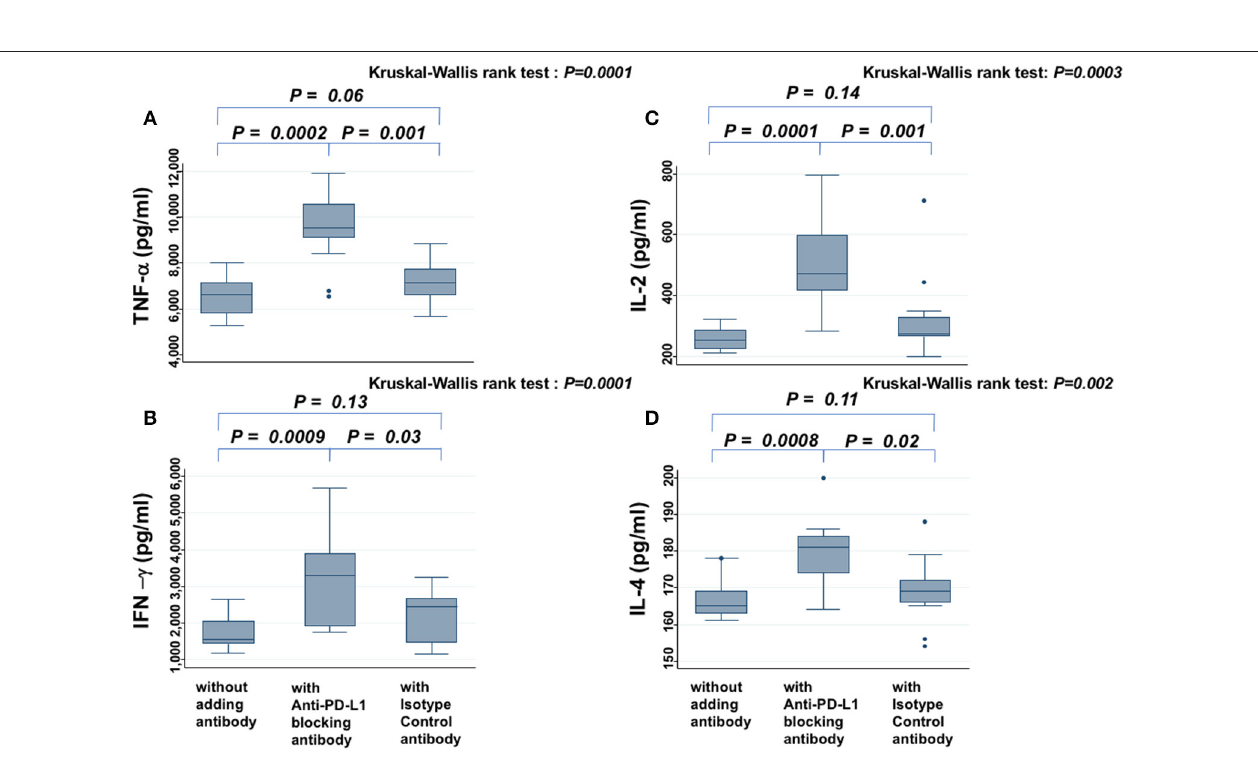
FIGURE 4 | Cytokine assay. Levels of TNF- α (A) , IFN- γ (B) , IL-2 (C) , and IL-4 (D) secreted from PBMCs in the presence of PHA and PW’s serum are compared among samples without antibody, those treated with anti-PD-L1 blocking antibody, and those treated with isotype control antibody. The Kruskal-Wallis rank test (KW test) was used for comparisons among the three groups. If there was a significant difference, the Mann-Whitney test was used to compare two groups.